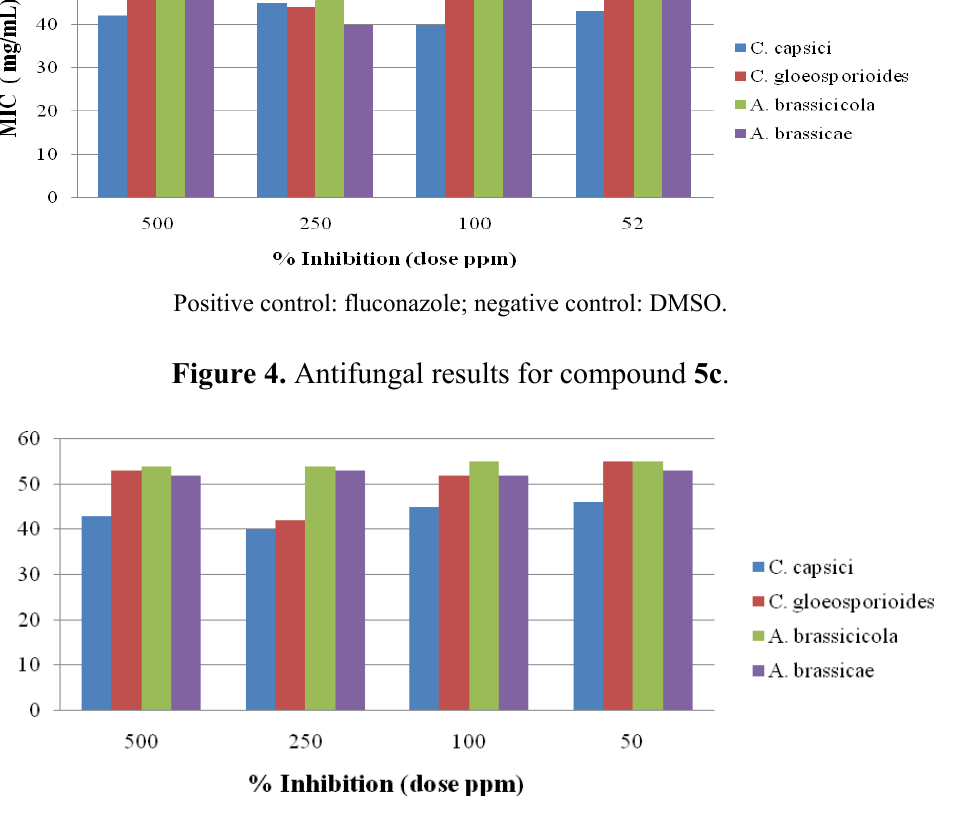
Positive control: fluconazole; negative control: DMSO. Figure 5. Antifungal results for compound 5d .